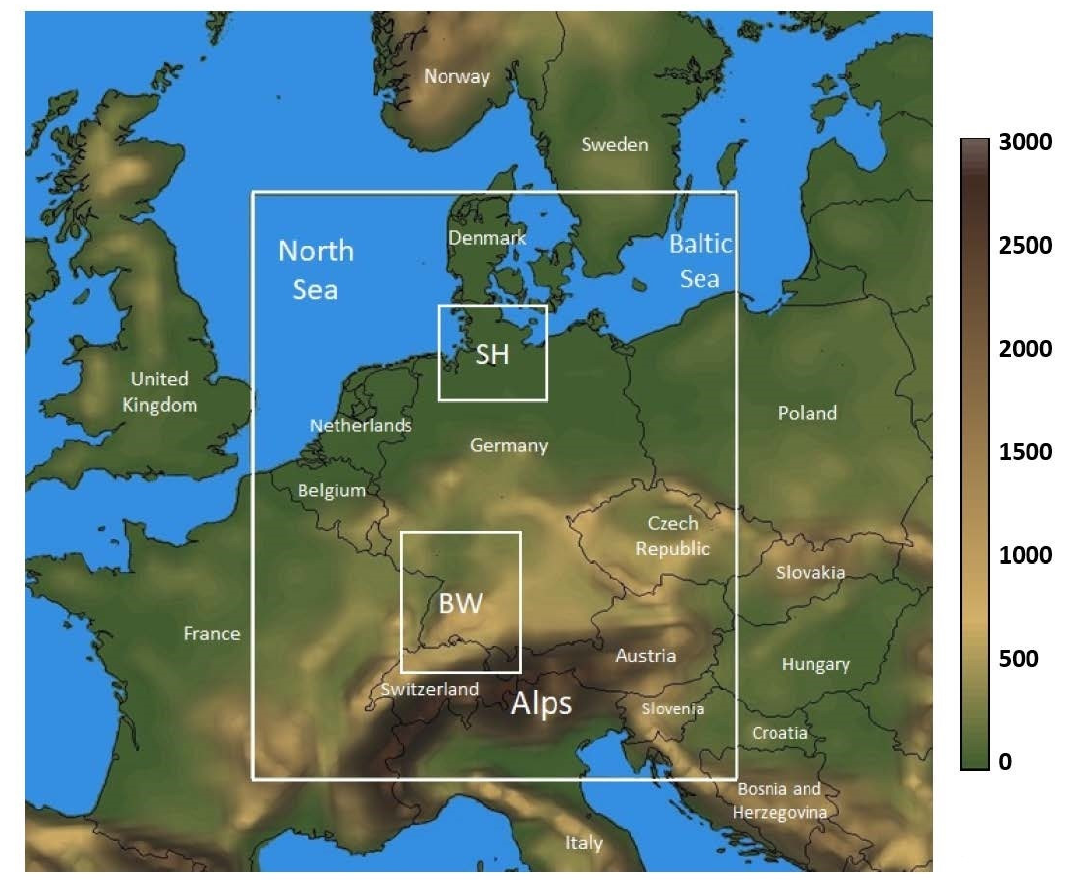
Figure 1. WRF model spatial configuration. The color bar depicts elevation (m).